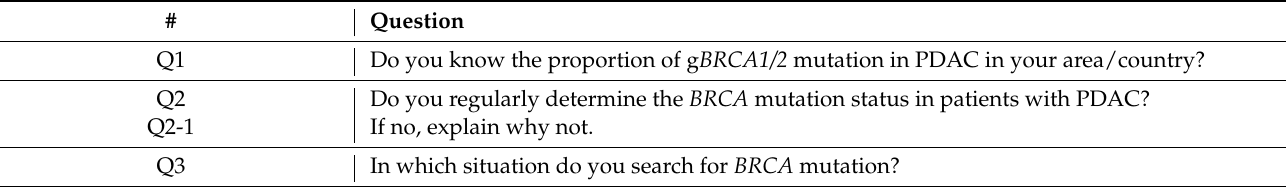
Table 1. Overview of the 27-question survey on the role of DNA damage repair in pancreatic ductal adenocarcinoma. DDR, DNA damage repair; HRD, homologous recombination repair-deficient; PDAC, pancreatic ductal adenocarcinoma; PFS, progression-free